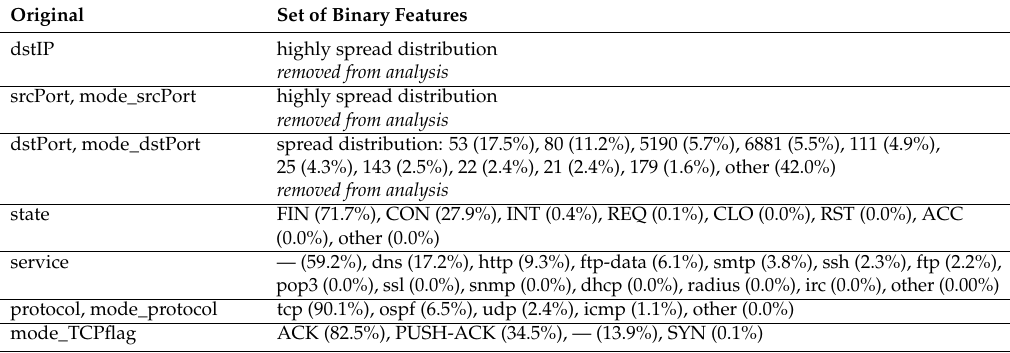
Table 3. Nominal features and equivalent binary features.